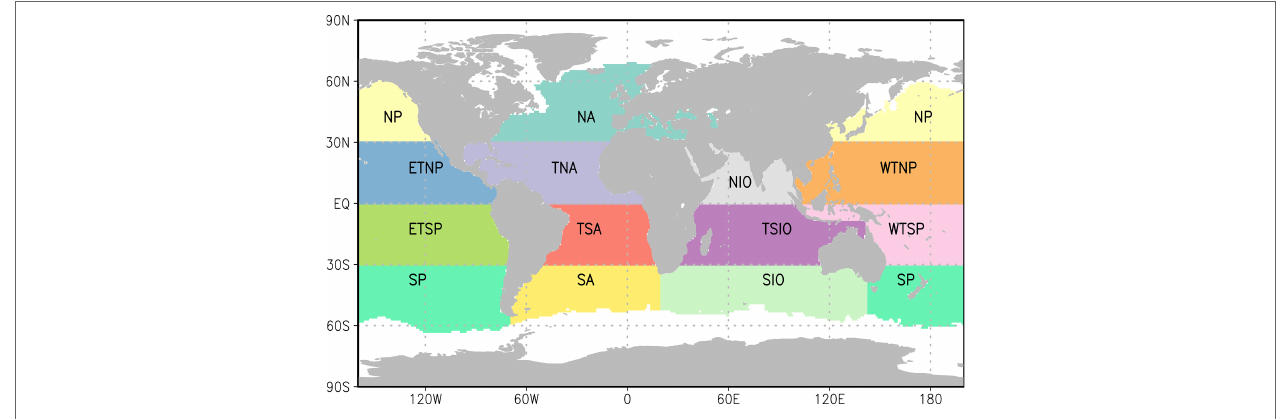
FIGURE 1 | Areas used to calibrate the wave model and compute the regional averaged trends and time